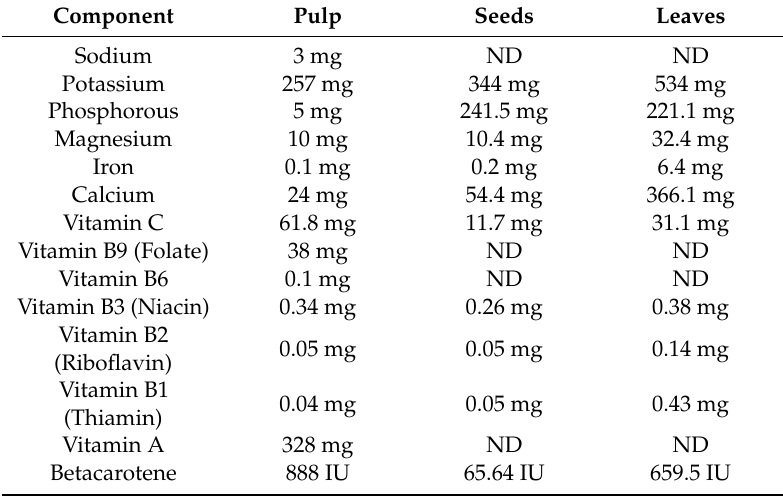
Table 2. Value of the minerals and vitamins of Carica papaya L. (papaya) per 100 g of ripe fruit pulp, seeds and leaves [7,19].